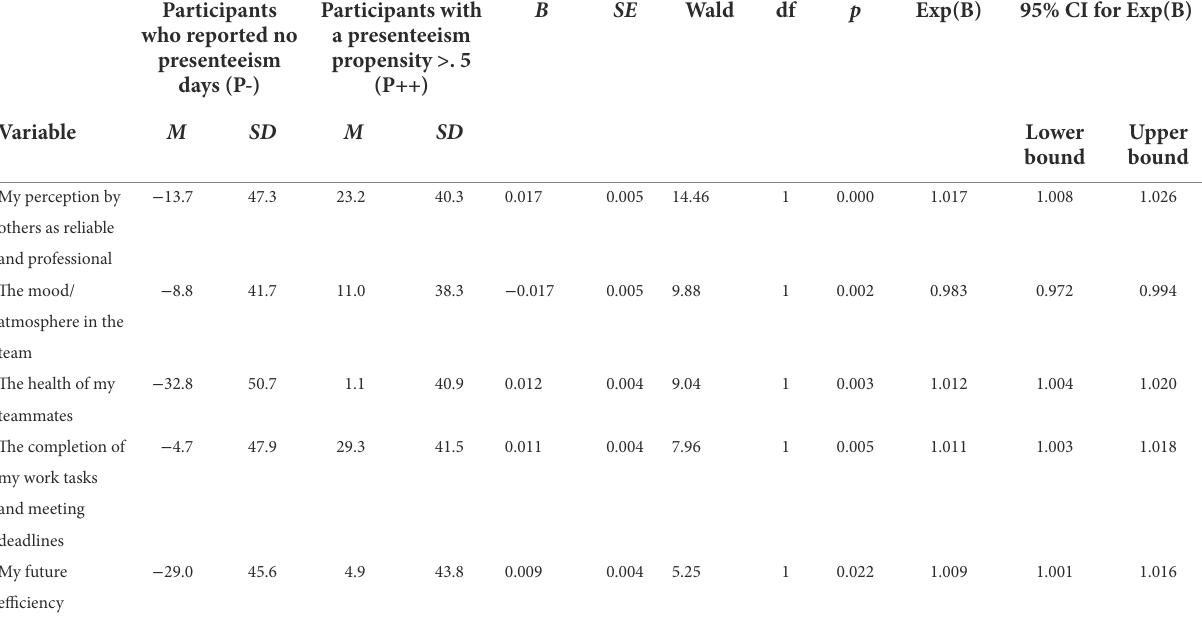
TABLE 4 Results of the binary logistic regression with degree of presenteeism propensity (high, zero) as dependent variable (significant variables only, N = 310).